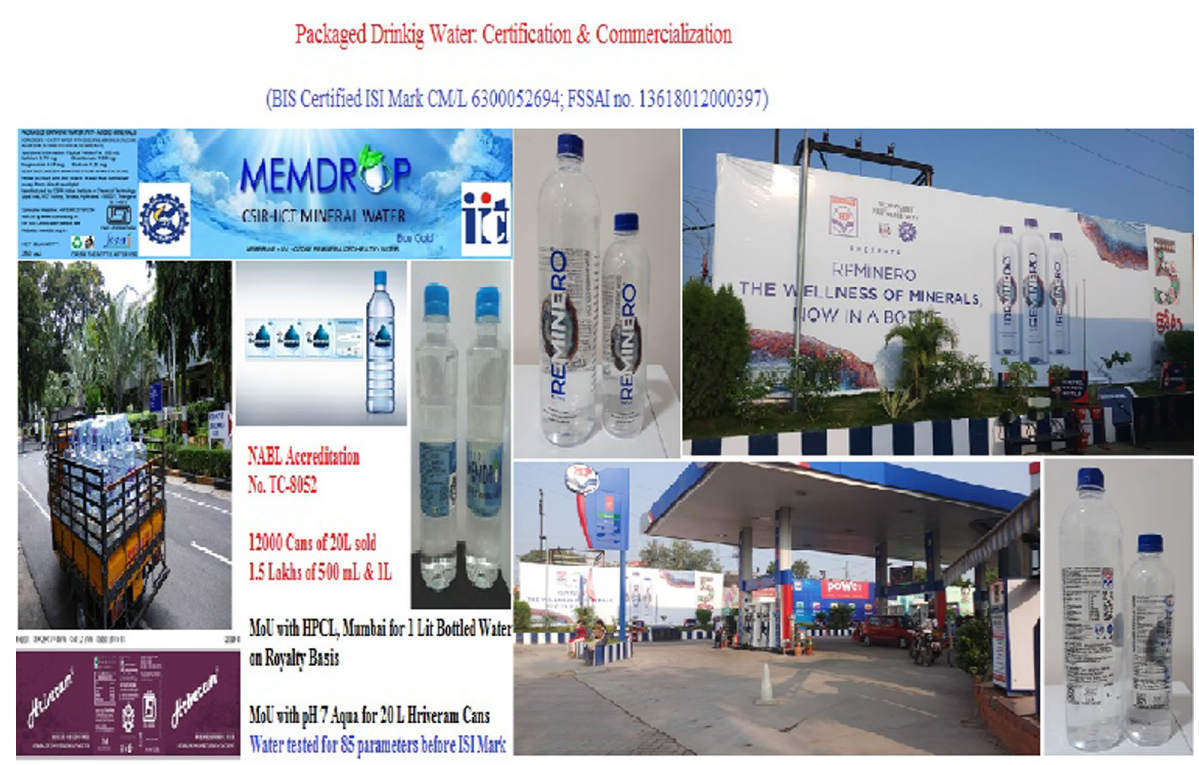
Fig. 13 Photographs of production and distribution of packaged drinking water of various